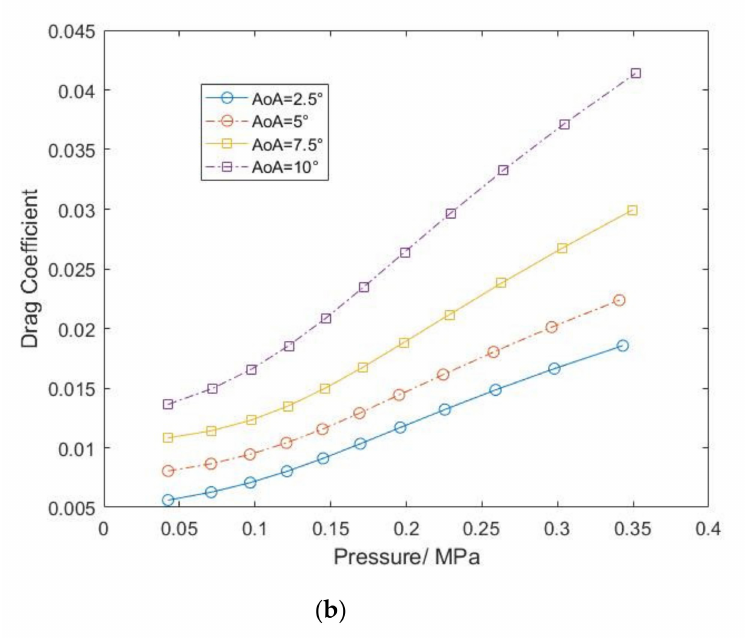
Figure 15. Pressure vs. aerodynamic coefficients: ( a ) pressure vs. lift coefficient; ( b ) pressure vs. drag